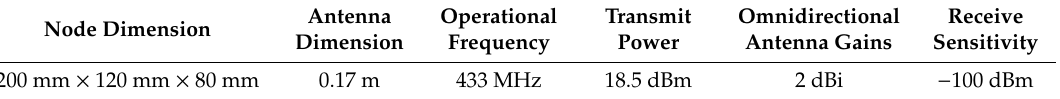
Figure 5. Schematic of the onsite experiment in this paper. Table 1. Specifications for wireless sensor nodes.